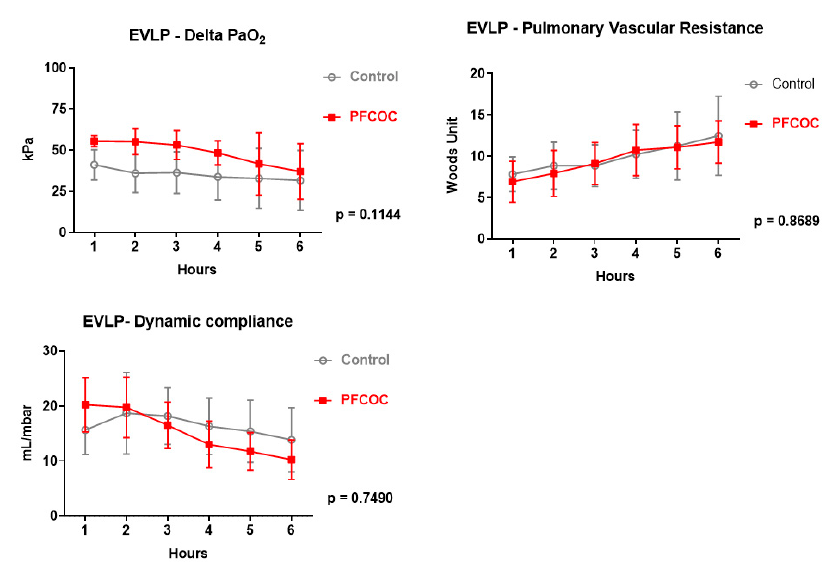
Figure 2. Lung physiology and metabolism were monitored during the 6 h EVLP period. Two-way analysis of variance (ANOVA) was used for repeated measures. Control: control group, PFCOC: perfluorocarbon-based oxygen carrier group.